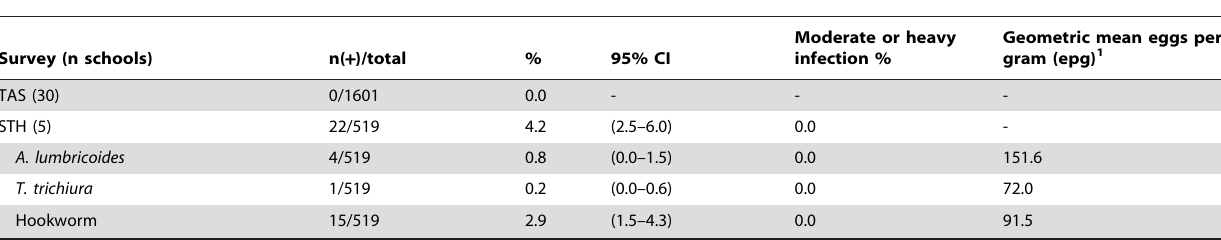
Table 4. Benin TAS and STH survey results.